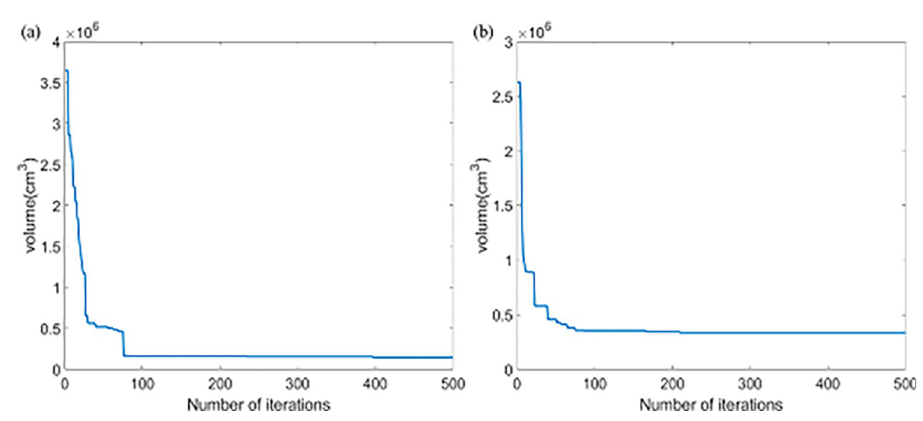
Fig 5. The fitness mean values of the global best particles: (a) Co-60, (b)